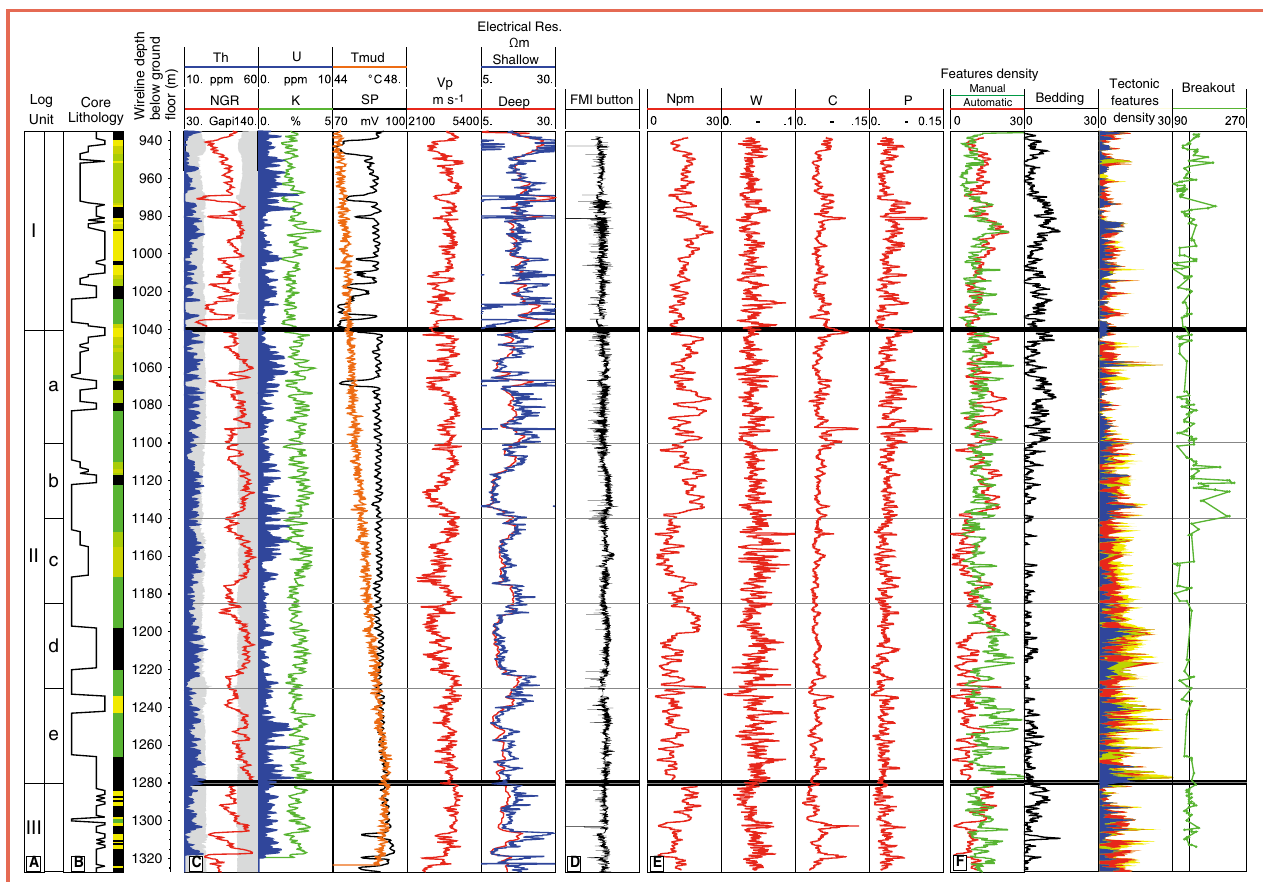
Figure 4. ICDP Taiwan Continental Drilling Project Hole B. [A] log units; [B] core units and lithology inferred from core data; [C] standard scalar logs: natural gamma radiation (NGR), thorium (Th), uranium (U), potassium (K), mud temperature (Tmud), spontaneous potential (SP), sonic velocity (Vp), shallow and deep electrical resistivities; [D] one button Fullbore Formation MicroImager (FMI) microresistivity log; [E] averaged density (Npm), size (W), electrical contrast (C) of detected features (singularities in microresistivity log) and product P (P = Npm x W x C); [F] density of sedimentary beds and structural features and orientation of breakouts recognized from visual analysis of the FMI